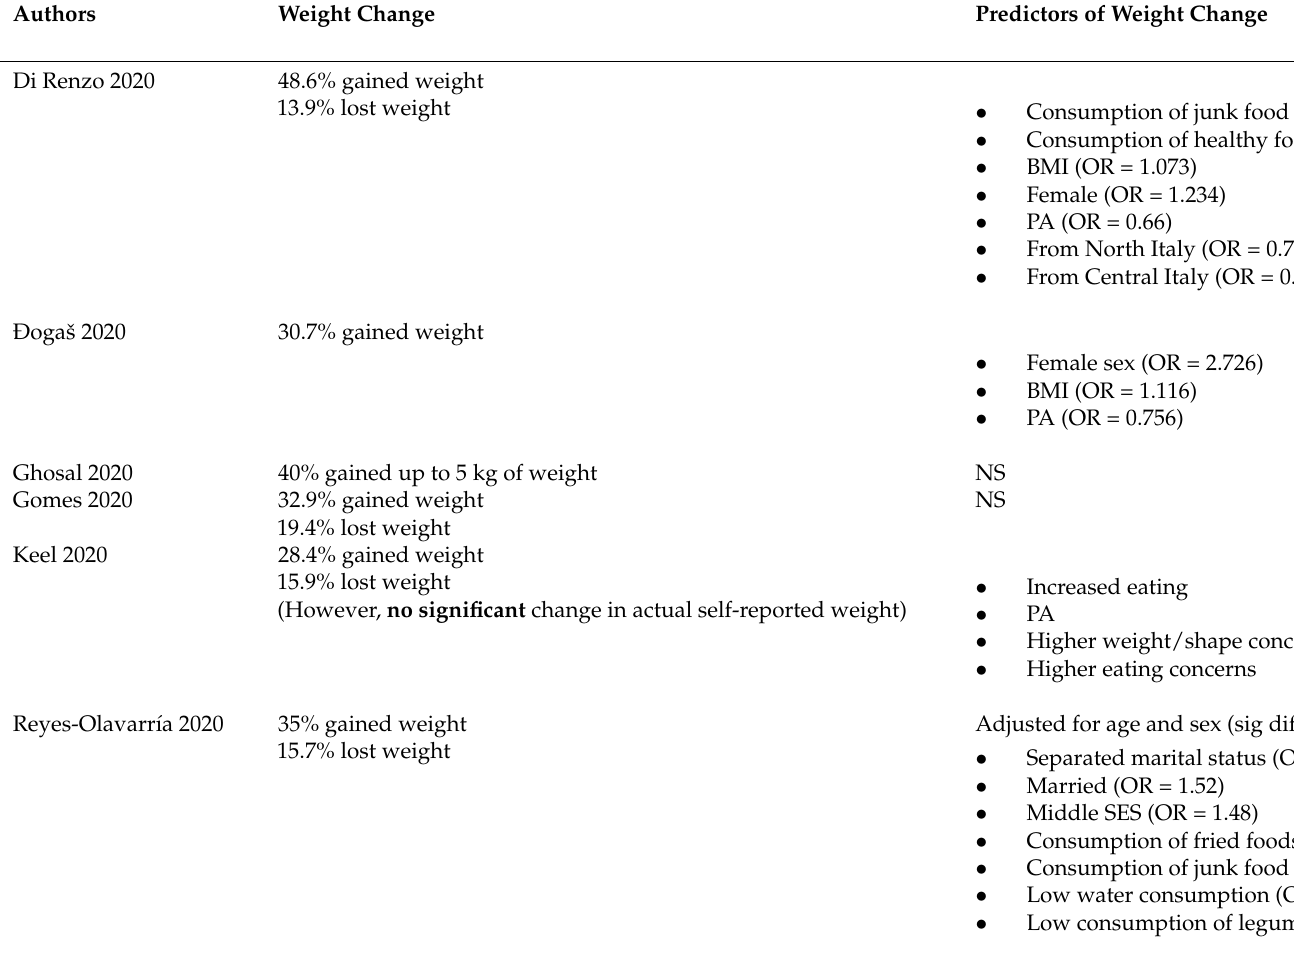
Table 3. Changes in weight and the corresponding predictors during the COVID-19